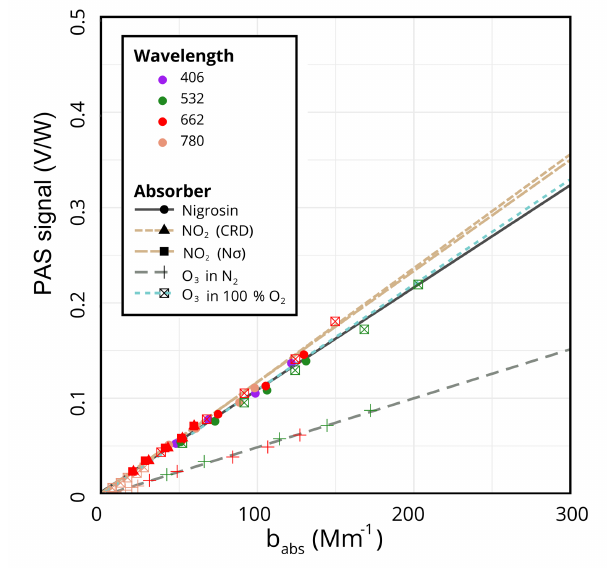
Figure 2. Calibration curves from various methods. Points are col- ored by